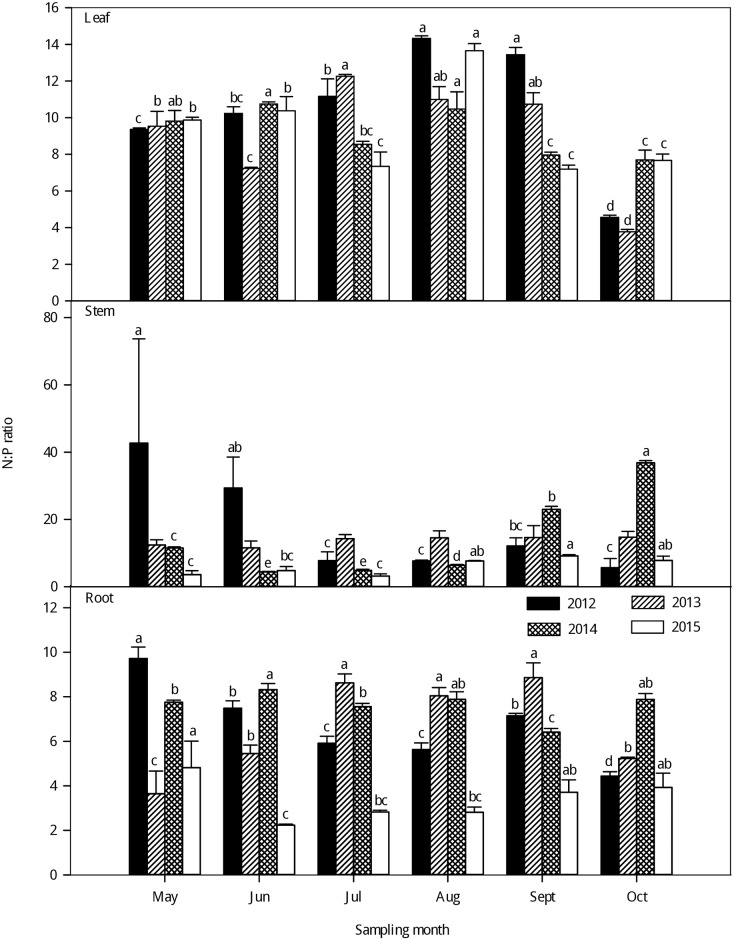
Seasonal variations in the N:P ratio (mean ± SE) in different organs of larch stands from 2012–2015.Different lowercase letters represent significant differences among different growing seasons at P < 0.05.